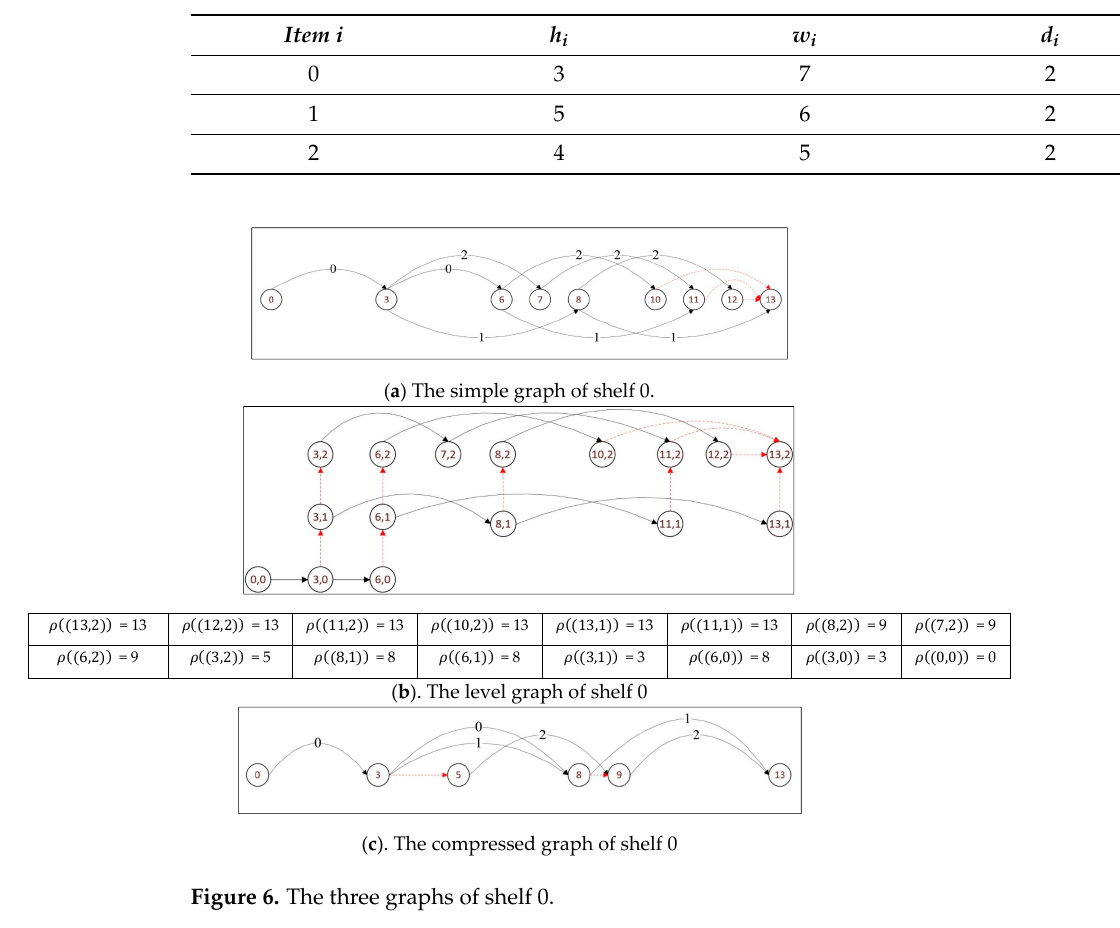
Table 2. Data of Example 3.